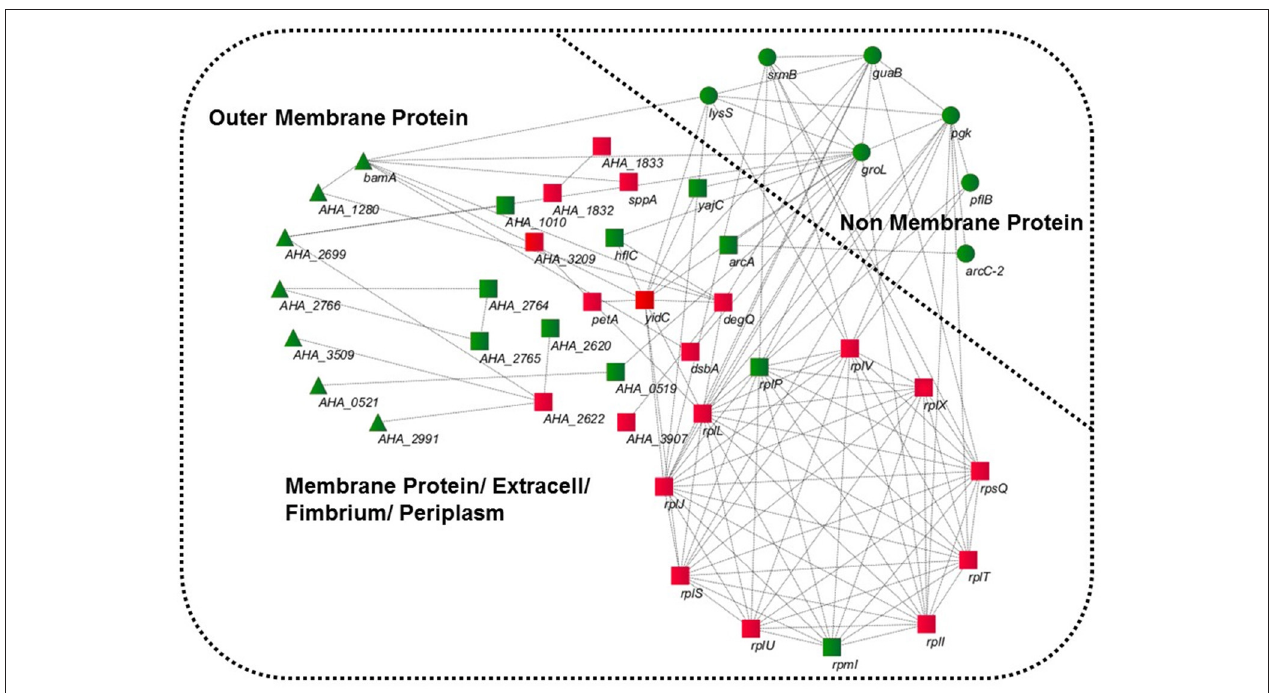
FIGURE 3 | STRING software prediction of PPI networks. Enrichment analysis of altered proteins in 16MIC OXY, Circles (green) represents non-membrane proteins including SrmB, GuaB, Pgk, ArcC-2, PlfB, GroL, LysS; triangles (green) represent outer membrane proteins including BamA ( AHA_1181 ), A0KLQ6 ( AHA_2699 ), A0KNY2 ( AHA_3509 ), A0KFM8 ( AHA_0521 ), A0KMJ4 ( AHA_2991 ), A0KLX3 ( AHA_2766 ), and OmpAII ( AHA_1280 ); squares represent inner membrane proteins or periplasmic proteins, mainly including RplP, RpmI, RplI, RplT, RpsQ, RplX, RplJ, RplS, RplL, RplU, RplV, DegQ, and YidC. All of gene names are in black, and the red and green in three shapes are the overexpressed and downregulated in proteomics, respectively.